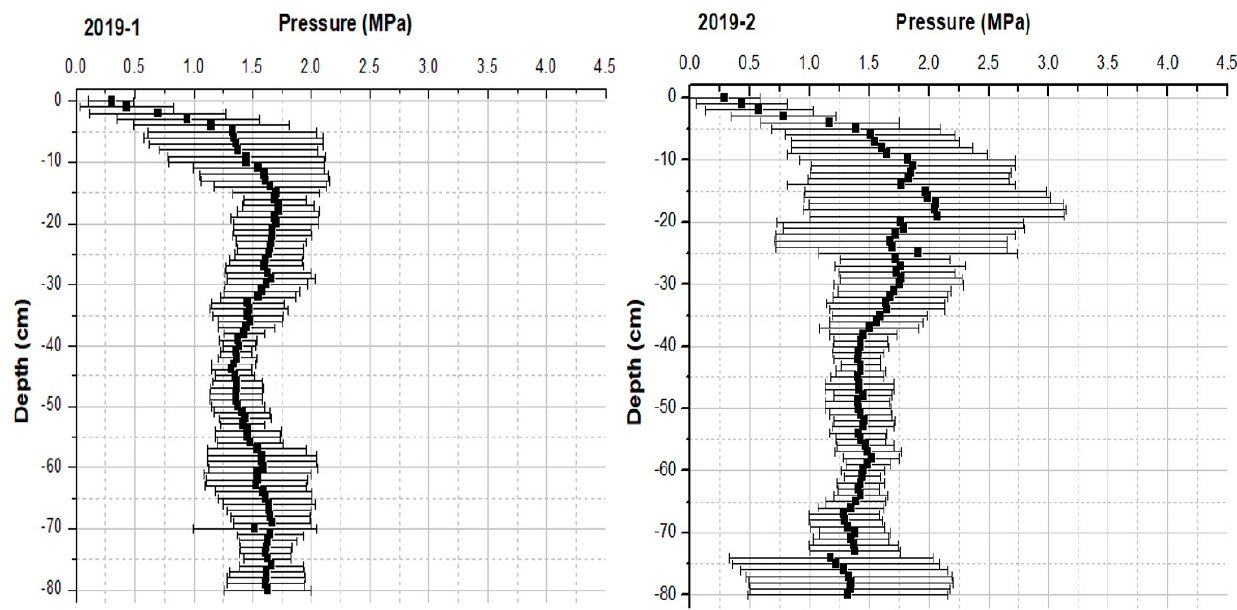
Figure 5. Soil penetration resistance values (average values with SD) in autumn 2019. Treatments were marked with numbers as follows: (1) weed control fabric; (2) weed control fabric + straw ( Ő sagárd, Hungary).